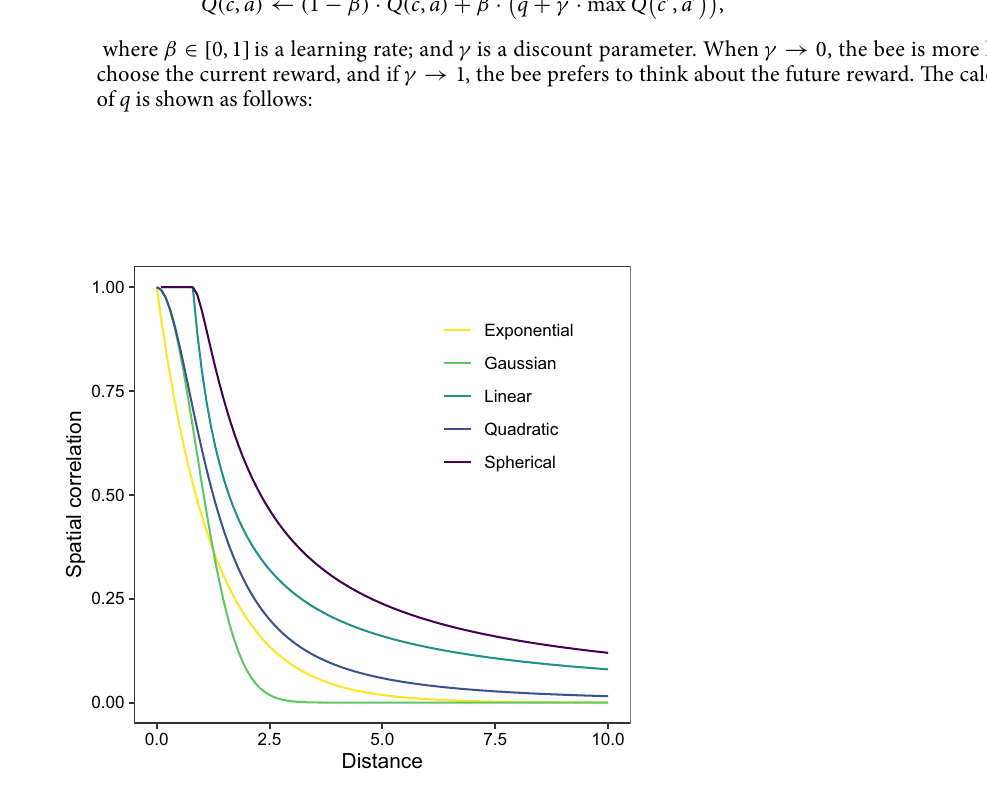
Figure 3. Variations in spatial correlation with distance when ρ = 0.8